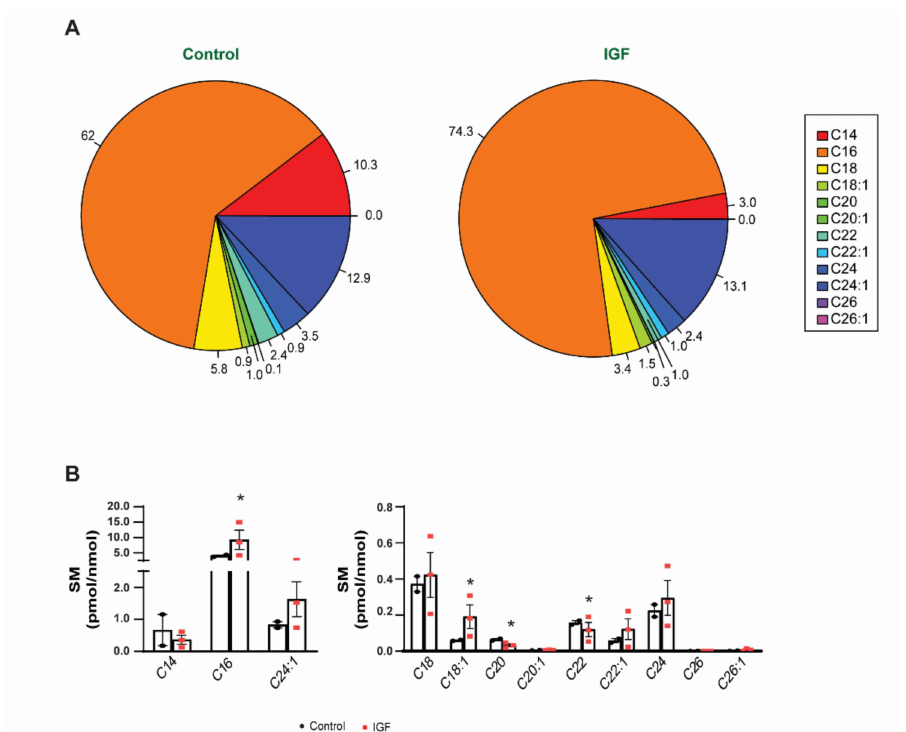
Figure 5. Effect of IGF-1 treatment on the sphingomyelin (SM) composition of myotube-derived EVs: ( A )—pie chart highlighting the SM species in EVs derived from the control and IGF-treated myotubes; ( B )—SM species normalized for the amount of lipid-associated phosphate (a measure of total phospholipids in each preparation). Data are presented in percentage ( A ) and as the mean ± SE ( B ) ( n = 3), with significance denoted by an asterisk compared to the